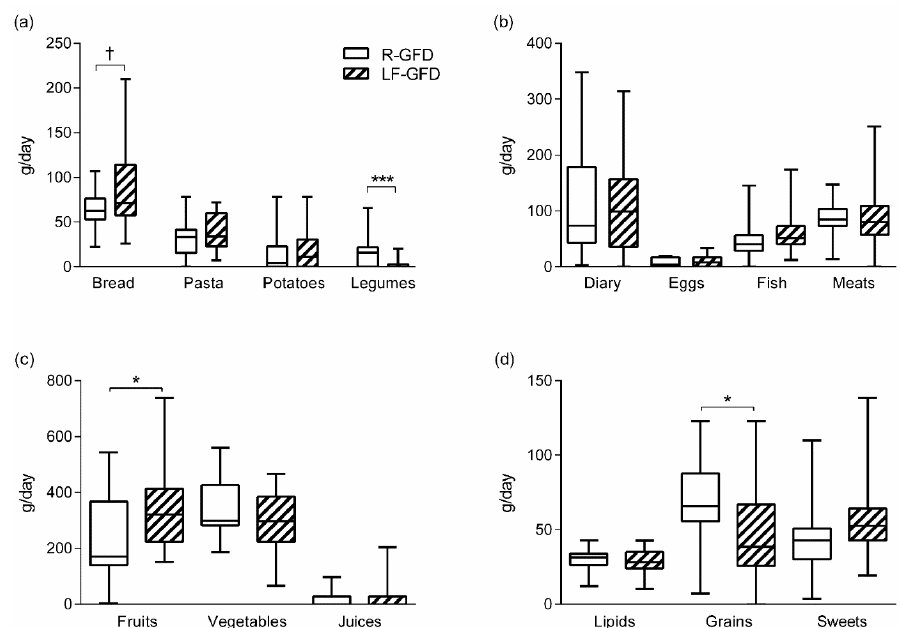
Figure 2. Food categories consumption between the groups at the end of intervention. Data as median. (horizontal line), interquartile range (p25-p75, box), and minimum and maximum (whiskers). ( a – d ) show to di ff erent food classifications. Wilcoxon’s Rank Sum Test: * p < 0.05; *** p = 0.0008; † p = 0.098. R-GFD: Regular gluten-free diet; LF-GFD: Low-FODMAP gluten-free